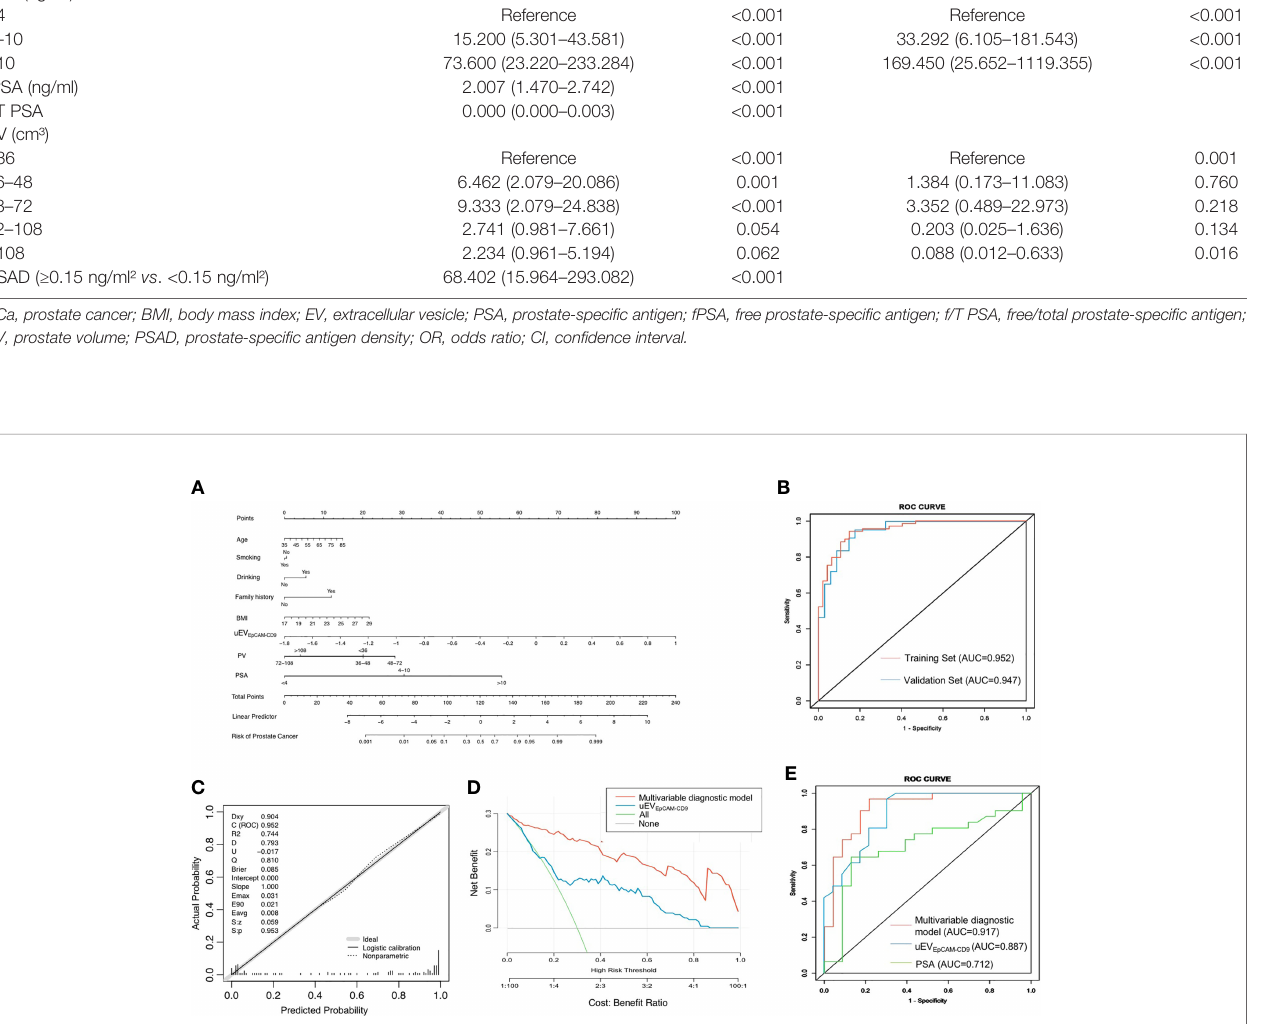
FIGURE 4 | A multivariate diagnostic model based on uEV EpCAM-CD9 for PCa. (A) The nomogram was constructed according to the results of multivariate logistic regression. (B) The ROC curve analysis of the multivariable diagnostic model in the training set and validation set. (C) The multivariable diagnostic model was calibrated in the internal validations. (D) The decision curve analysis of the multivariable diagnostic model and uEV EpCAM-CD9 . (E) The diagnostic performance of the model, uEV EpCAM-CD9 , and PSA in patients with PSA gray zone (4 – 10 ng/ml) including 23 PCa and 31 BPH. BMI, body mass index; uEV EpCAM-CD9 , Log urinary EpCAM-CD9-positive extracellular vesicles concentration (n.u); PV, prostate volume; PSA, prostate-speci fi c antigen; ROC, receiver operating characteristic; AUC, area under the